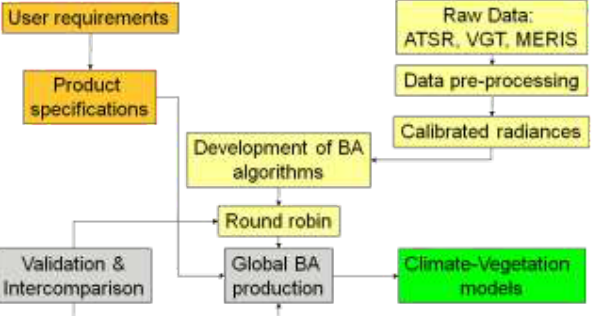
Figure 1: Modules of the fire_cci